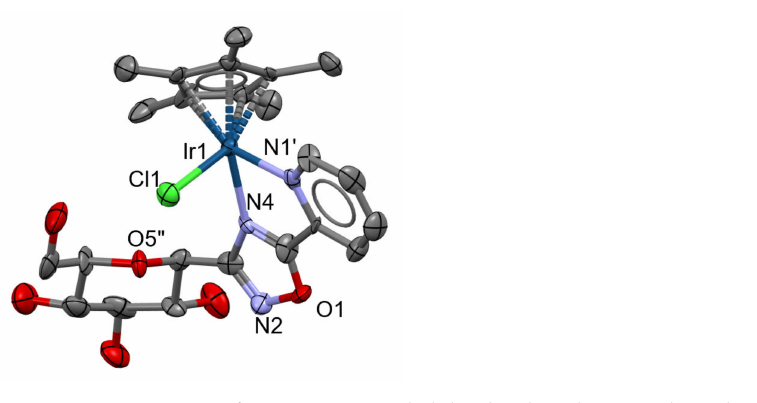
Figure 3. ORTEP view of Ir-2 at a 50% probability level, with a partial numbering scheme. Hydrogen atoms and the PF 6- counter ion are omitted for